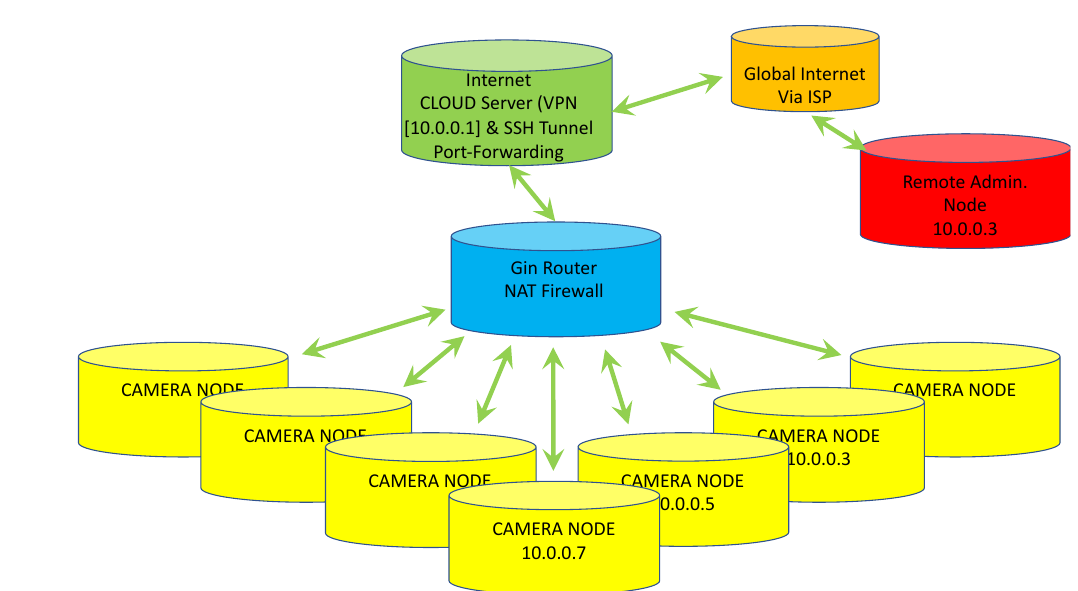
Figure 10. Screenshot of the PIDES-Viewer software that provides the user interface to the machine-vision plastic detection system.